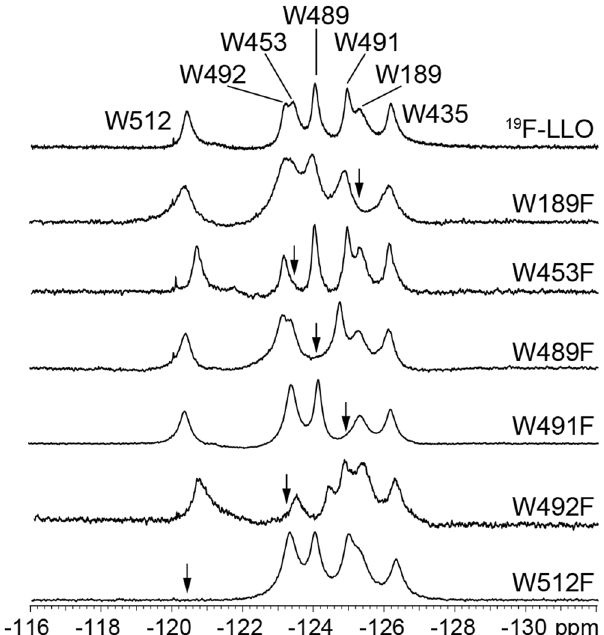
Figure 3. 19 F NMR spectra of 19 F-LLO and its Trp mutants in MES buffer. The protein concentration was between 0.1 to 0.3 mM. Arrows represent the lack of signal of the Trp residue that was mutated to (isotopically unlabelled) Phe. Assignment of Trp residues is given by residue number in 19 F-LLO spectrum.